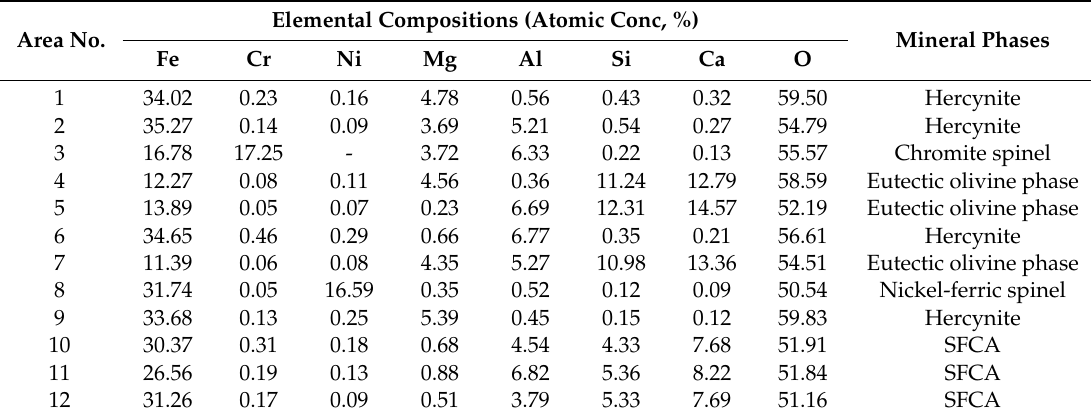
Table 4. EDS analysis results for areas in Figure 9.